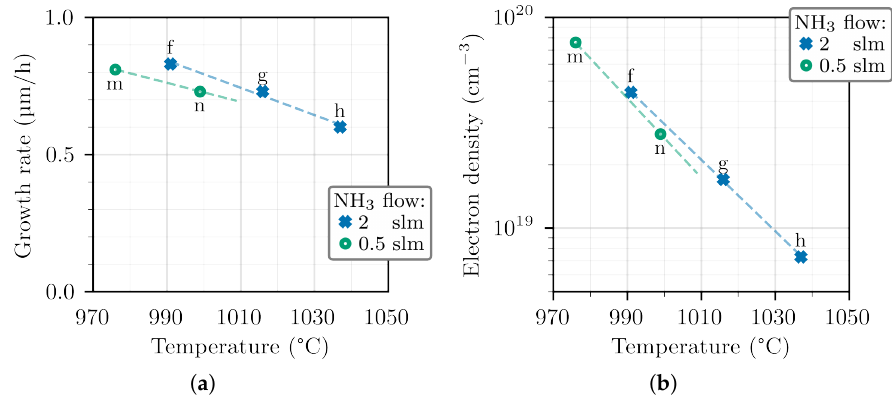
Figure 4. GR ( a ) and electrons density ( b ) in GaN:Ge layers grown at different temperatures and NH 3 flows, while the TMGa and GeH 4 flows are kept at 26.8 and 7.5µmol/min,